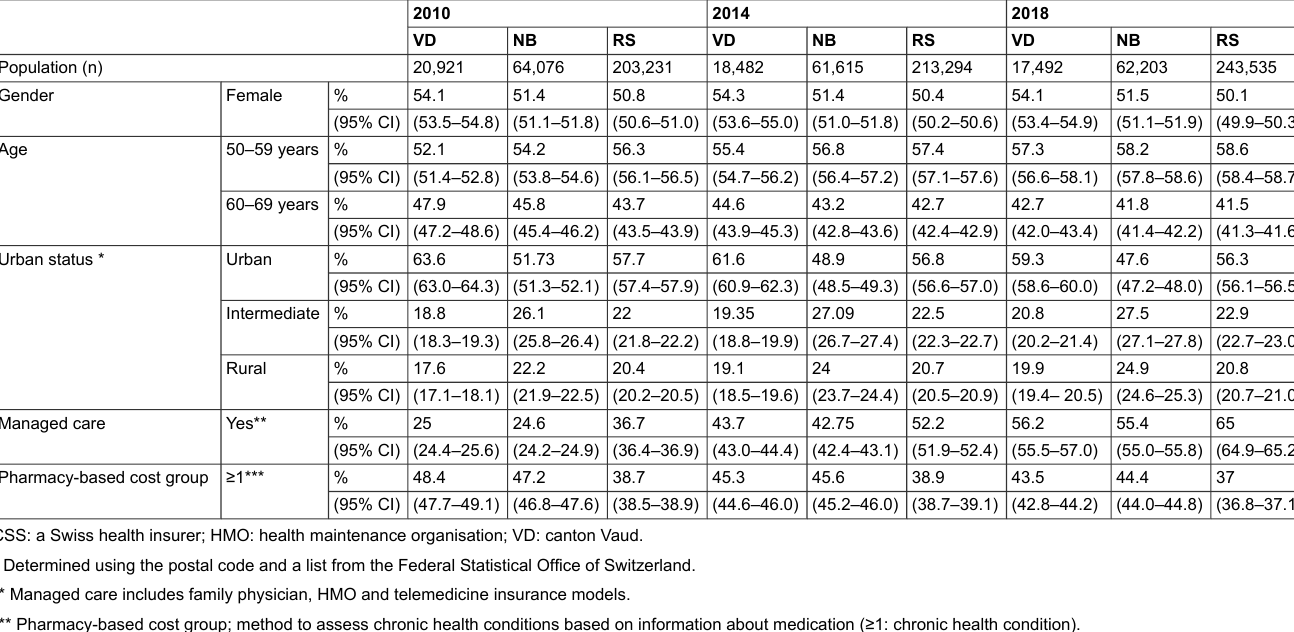
Table 1: Characteristics of the included population (aged 50–69 years) in Vaud (VD), neighbouring cantons and the rest of Switzerland, every 4 calendar years (2010–2018); CSS data- base. Exclusion criteria: moved, died or changed insurance during each calendar year. Comparison cantons: neighbouring cantons (NB): Geneva, Neuchâtel, Fribourg and Valais; RS: the rest of